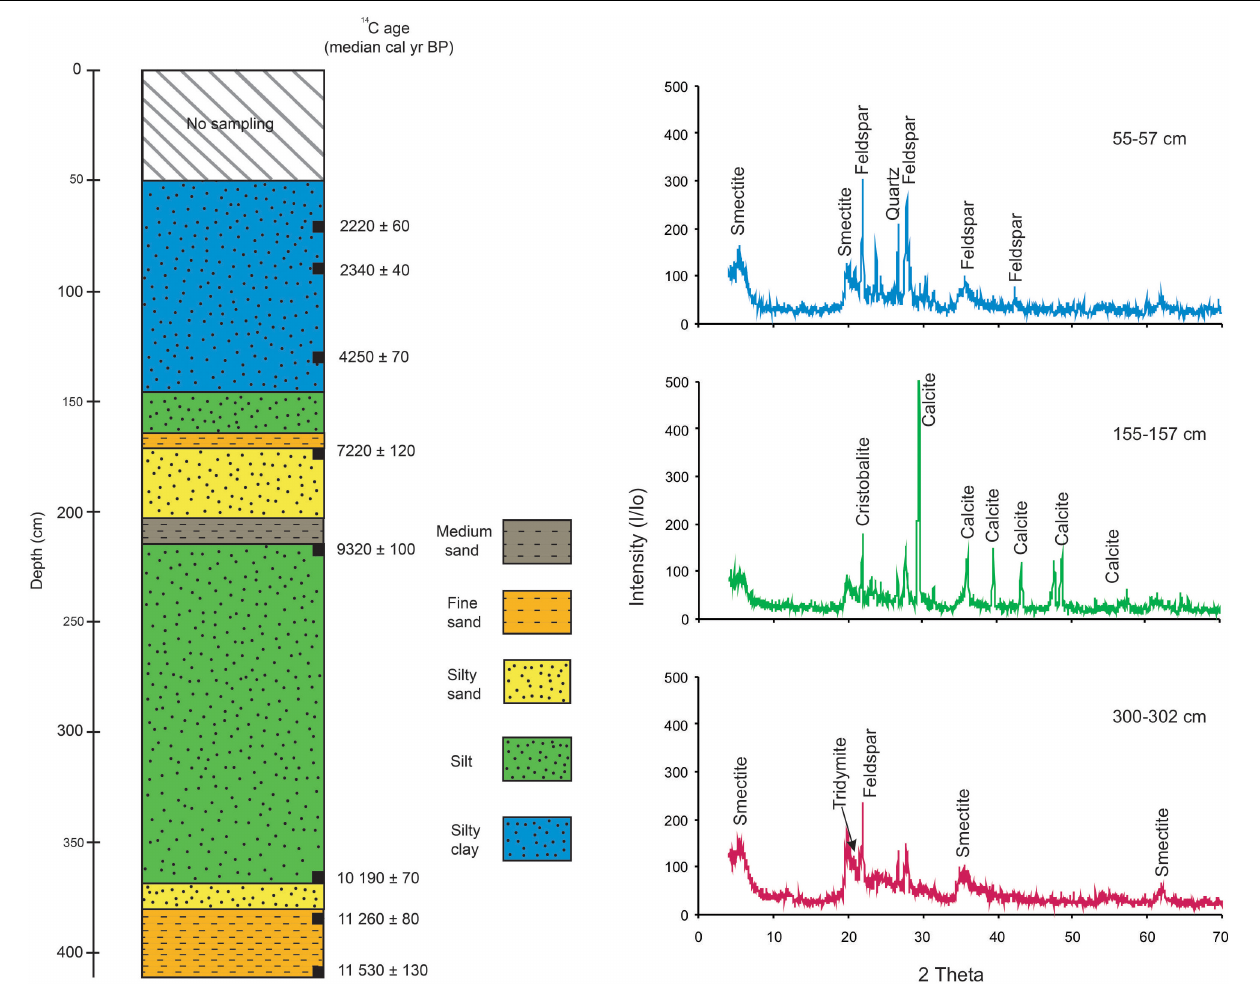
FIGURE 3 | Sediment texture between 412 and 50 cm depths in the core (COA-N2-2019) collected from southwestern margin of the present-day water body of Lake Coatetelco. Eight radiocarbon dates on bulk organic matter constrain this sequence between ∼ 11-5-2.1 cal ka BP. XRD charts show variable abundances of calcite, quartz, plagioclase (i.e., anorthite), smectite (i.e., montmorillonite), and cristobalite in the